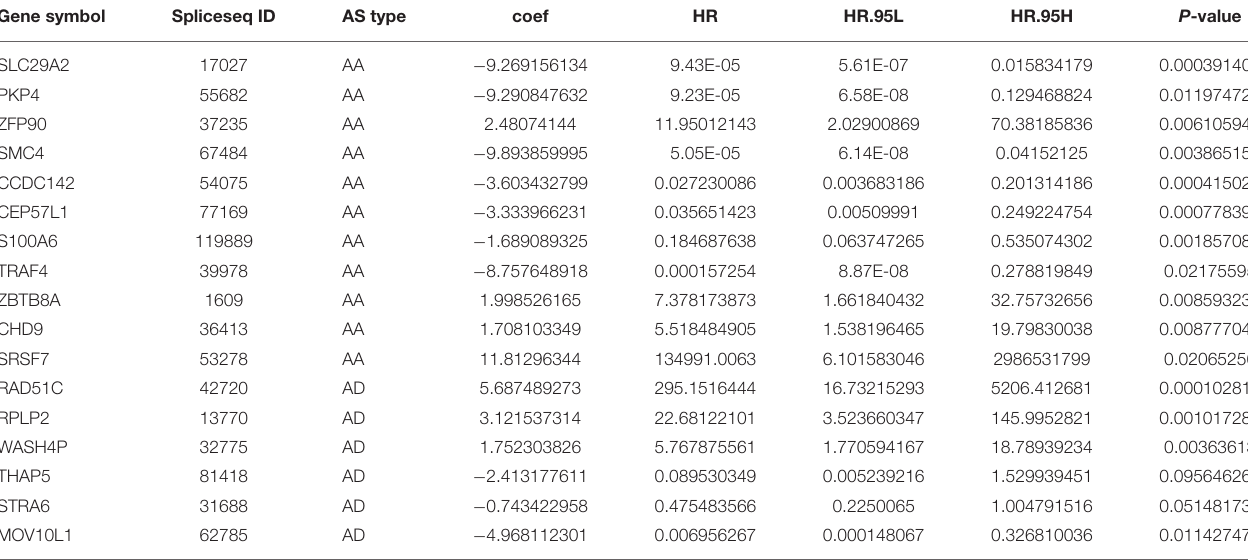
TABLE 2 | Information of AS events used for construction of the final prognostic